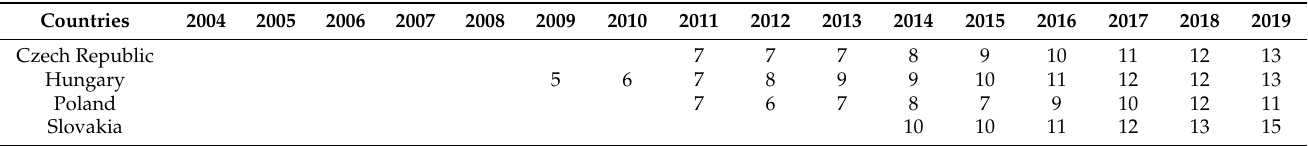
Table 5. The delay of Poland, the Czech Republic, Hungary and Slovakia in relations to Germany (variant II).